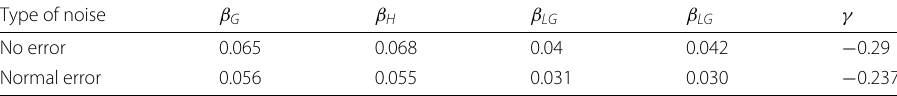
Table 5 Parameter estimates with measurement errors Type of